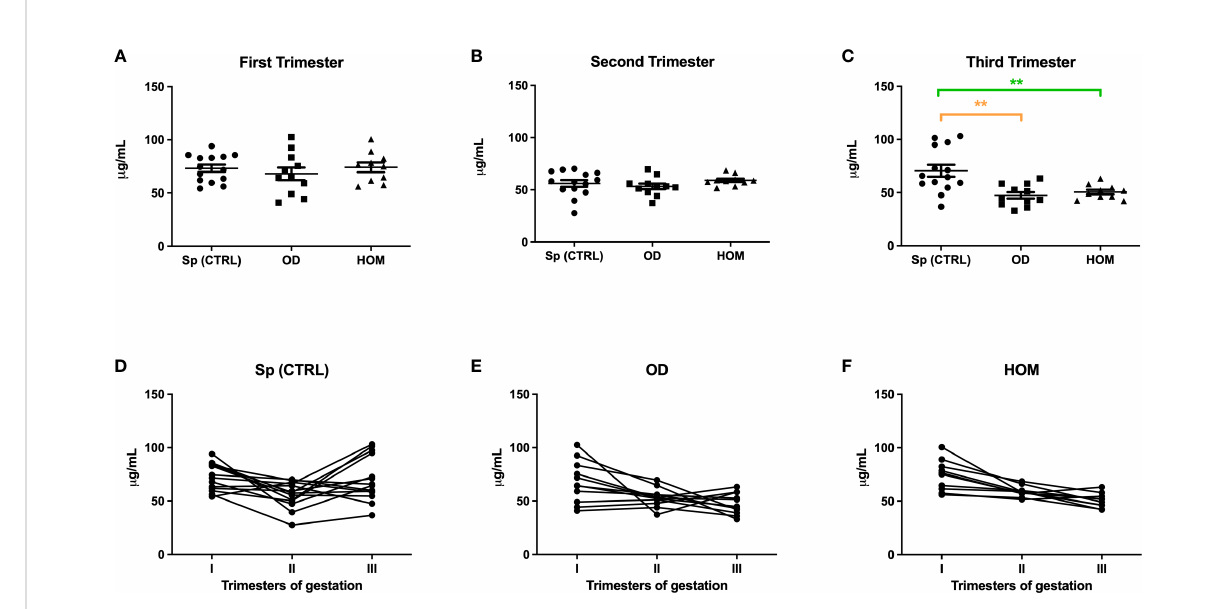
FIGURE 5 C1q levels during Sp CTRL, OD and HOM pregnancies. Serum levels of C1q were measured in fi rst (A) , second (B) and third (C) trimester, represented as box-plot graphs. No differences were observed in the fi rst and second trimesters, while C1q was signi fi cantly lower in the serum of OD and HOM pregnancies in the third trimester compared to Sp CTRL, in a manner consistent with the data previously published for PE patients by Agostinis et al. (17). (**p<0.01, T-test). The before-after plots (D-F) describe the changes in C1q levels throughout pregnancy.